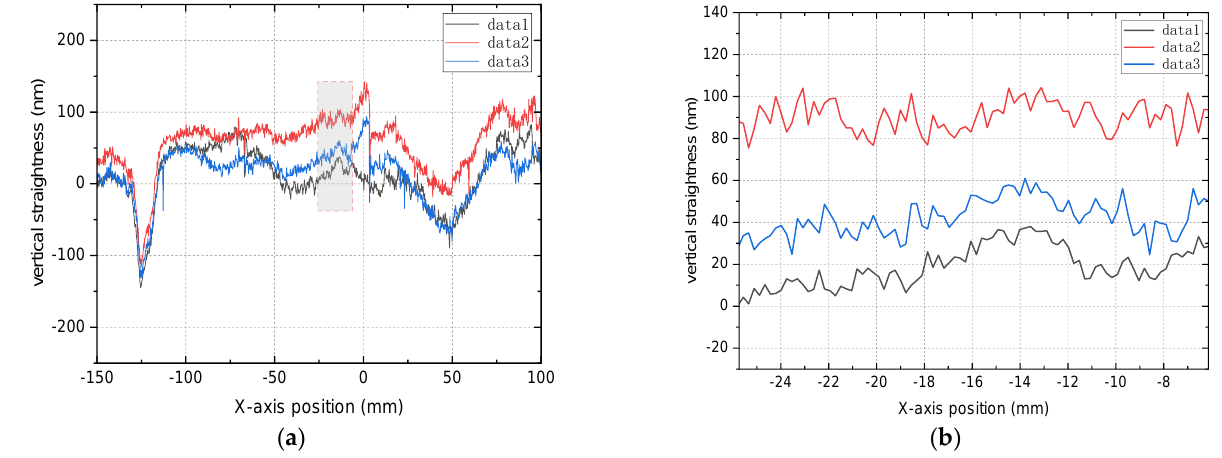
Figure 9. Straightness measurement in Y -axis vertical direction.